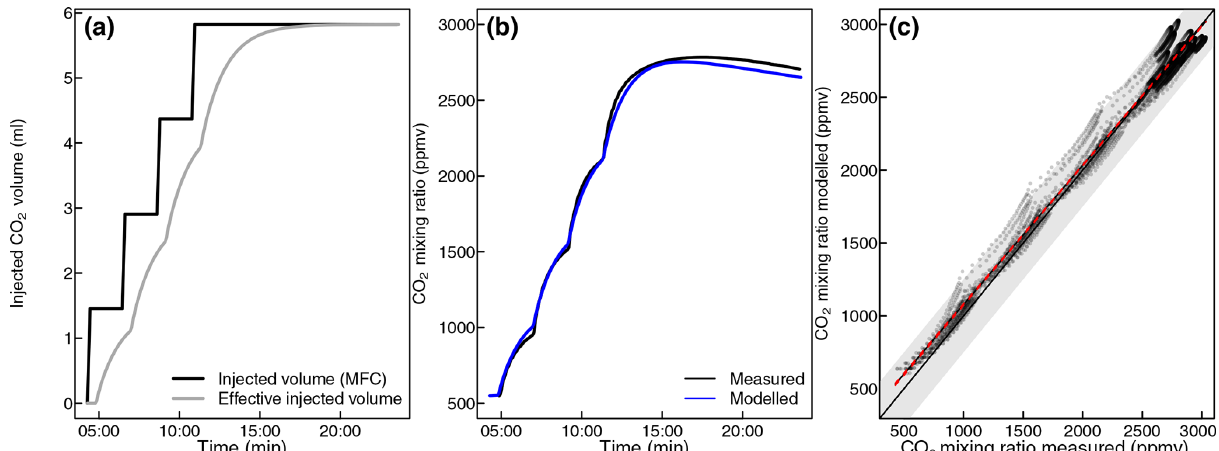
Figure 3. Injected CO 2 volume (quantified by mass flow controller) and effective injected CO 2 volume during a leak check test of an empty chamber (a) . The effective volume takes into account delays due to mixing in different parts of the system. Further, measured and modelled CO 2 mixing ratios during the same closure (b) . Moreover, comparison of measured against modelled CO 2 mixing ratios during all 20 leak checks performed during the test measurements (c) . The solid black line indicates the equal measured and modelled mixing ratios, and the dashed red line indicates a linear regression between measured and modelled data. The shaded grey area indicates that the difference between measured and modelled values was less than